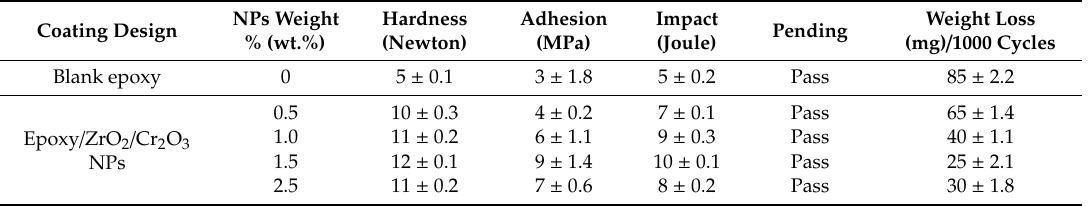
Table 2. Mechanical resistance of ZrO 2 / Cr 2 O 3 epoxy nanocomposite coating films at di ff erent at Table 2. mechanical resistance of ZrO 2 /Cr 2 O 3 epoxy nanocomposite coating films at different at di ff erent ZrO 2 / Cr 2 O 3 NPs loading. different ZrO 2 /Cr 2 O 3 NPs loading.